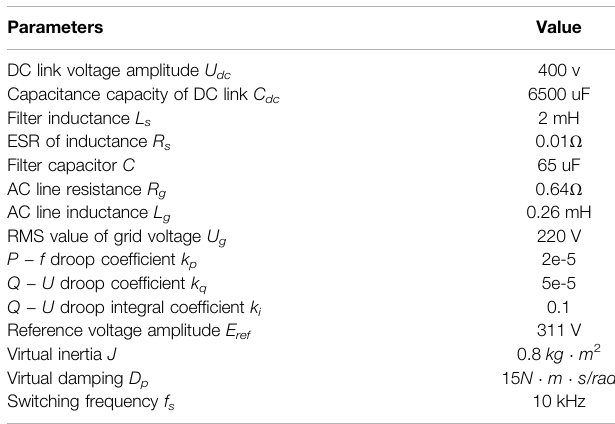
FIGURE1| Topologyandbasicblockdiagramofthesingle-phaseVSG.